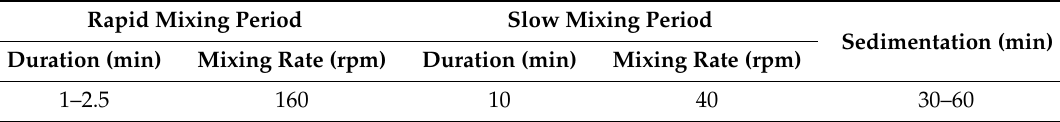
Table 3. Experimental conditions of coagulation using simulated surface water samples.